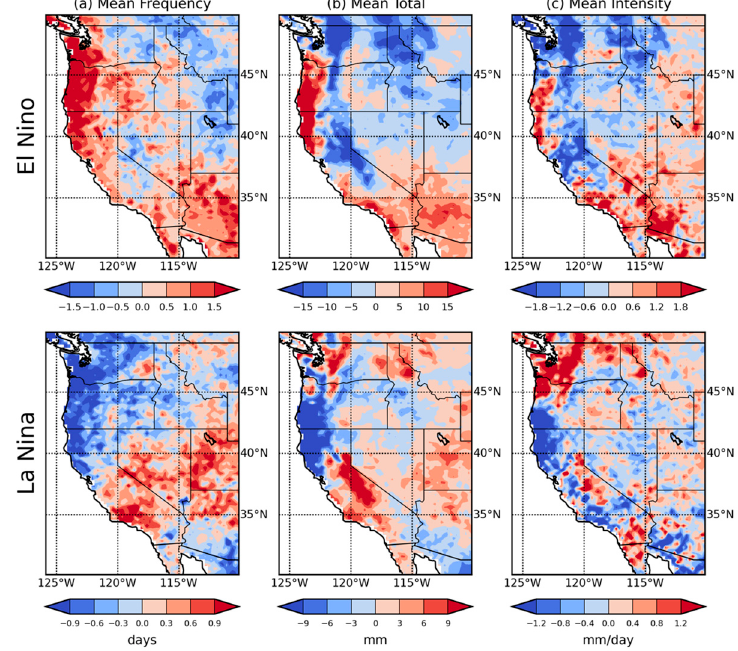
Figure 11. The averaged anomalies for El Niño events ( top ) and La Niña events ( bottom ) for winter season precipitation ( a ) frequency, ( b ) seasonal total, and ( c ) mean daily intensity.